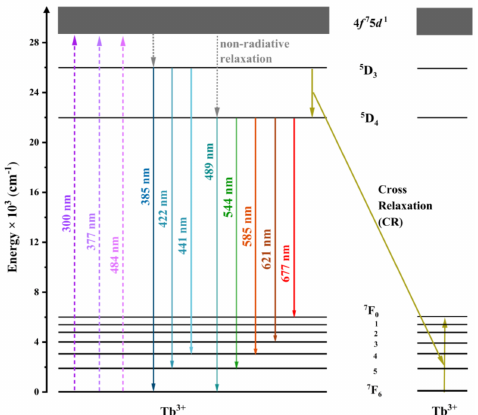
Figure 14. Energy-level-transition diagram of Tb 3+ ions in the yttria-stabilized zirconia